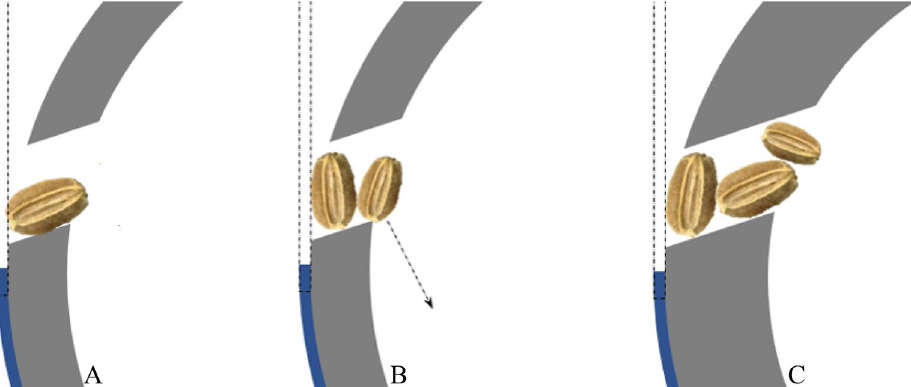
Figure 3. Possible seed loading scenarios of carrot seeds into the seed cell, ( A ) the seed is loaded to the cell at slant position; ( B ) seed is loaded at the vertical position; and ( C ) seed cell with larger